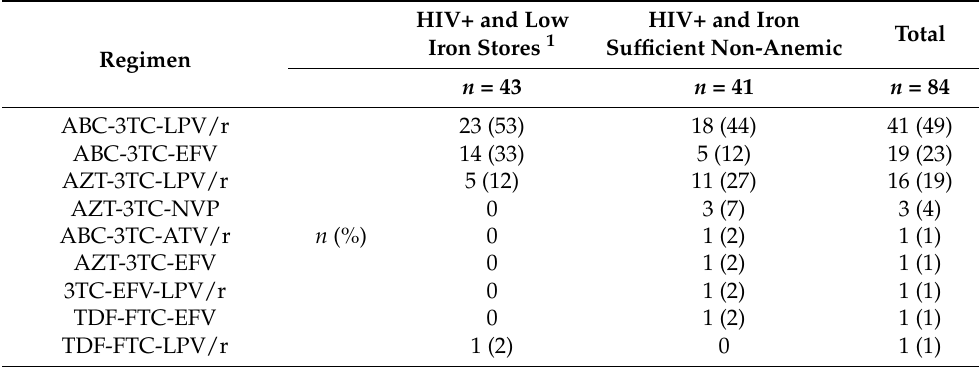
Table A1. Antiretroviral regimens ( n = 84).